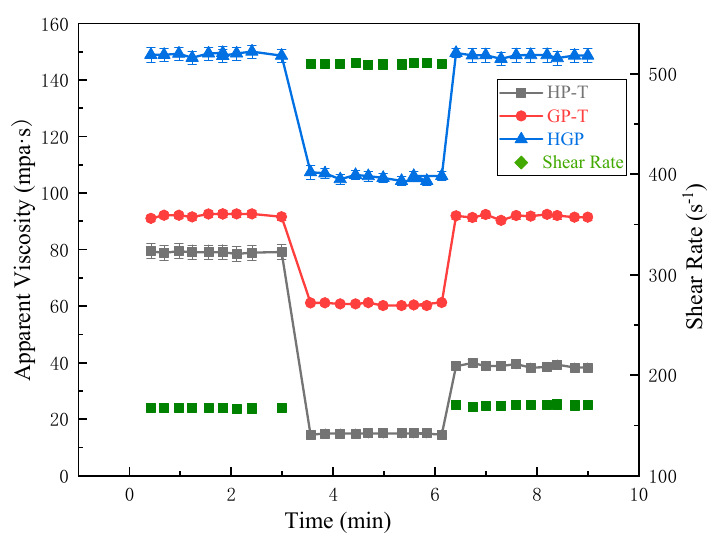
Figure 12. The HGP, GP-T, and HP-T apparent viscosity relative to alternating shear rate. The polymer will experience shear and temperature increase in the reservoir. Thus, it is necessary to evaluate the behaviors of polymers in formation water. In the experiment, formation water of the SZ1-1 oilfield in the Bohai Sea was used to prepare 0.6 wt.% polymer solution at 25 ◦ C; the formation water composition is shown in Table 2. Table 2. Formation water ion